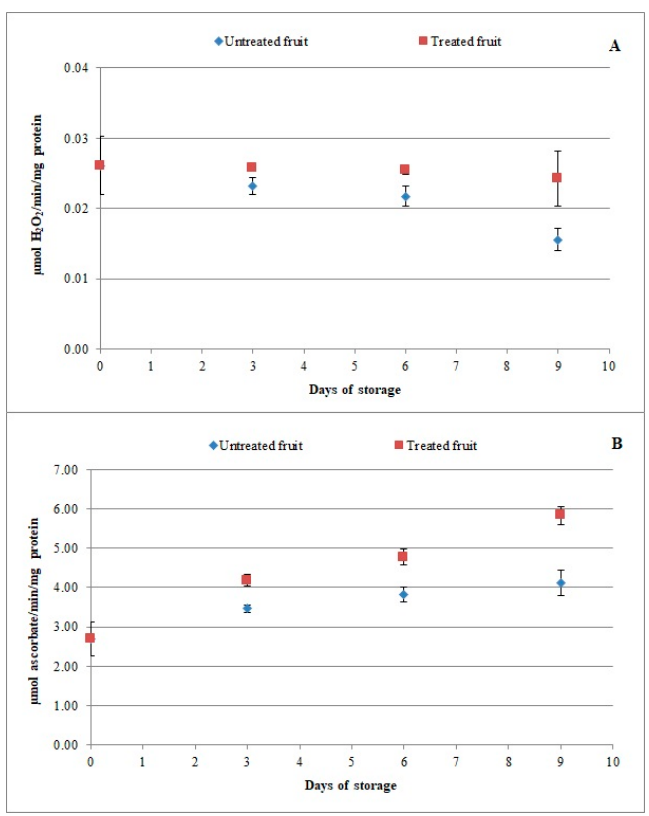
Figure 1. Activity of catalase (CAT) ( A ), ascorbate peroxidase (APX) ( B ) in uncoated (untreated) and chitosan-based coated figs (treated fruits) at harvest (0) and after three, six and nine days of cold storage at 4 °C. Error bars indicate standard deviation.